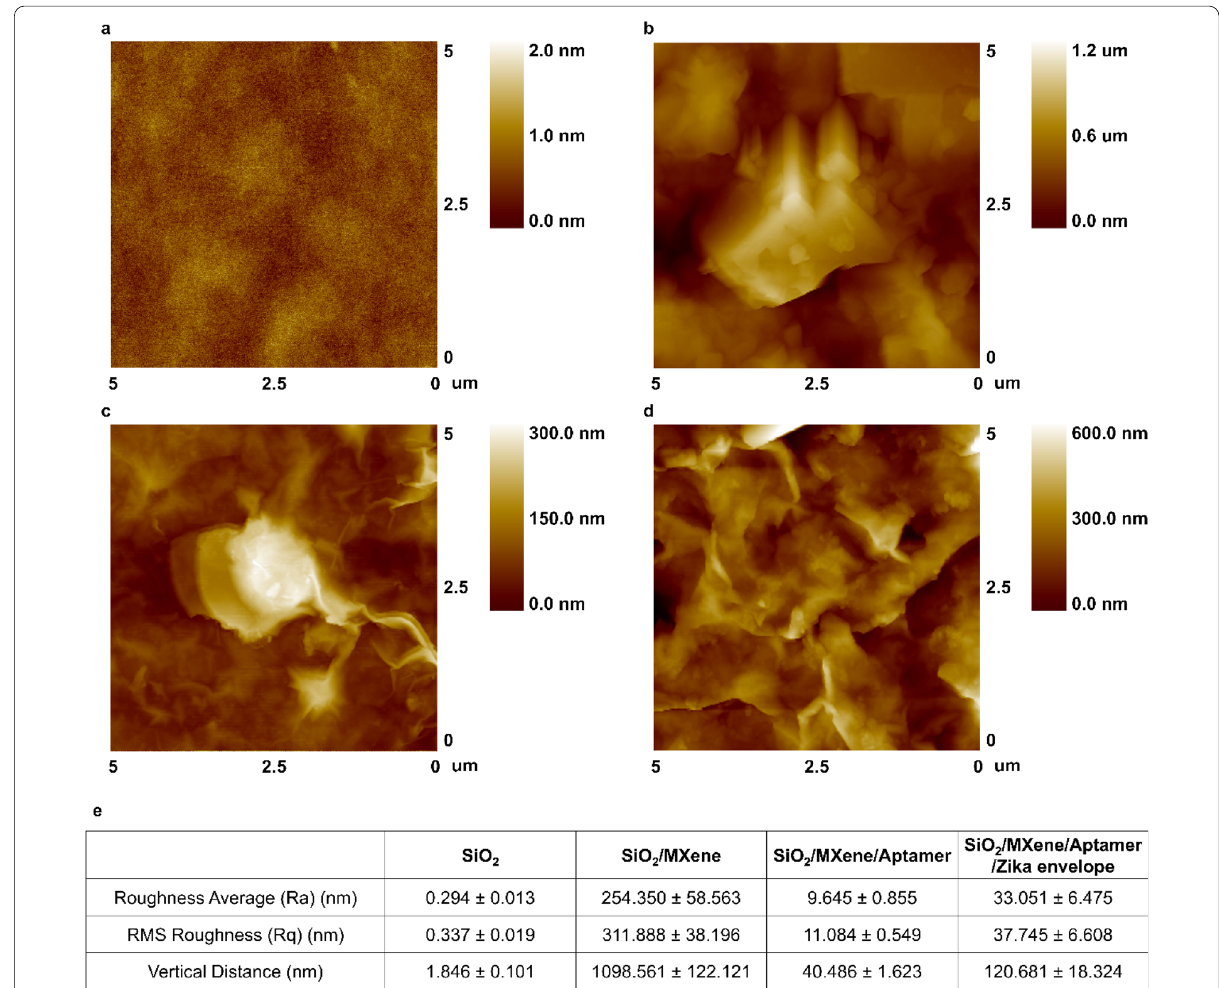
Fig. 3 a AFM image of SiO 2 substrate; b AFM image of MXene on SiO 2 substrate; c AFM image of MXene, Aptamer on SiO 2 substrate; d AFM image of MXene, Aptamer, and Zika virus envelope protein on SiO 2 substrate; e Surface Analysis of SiO 2 , MXene, Aptamer, Zika virus envelope protein using Roughness average, RMS and vertical